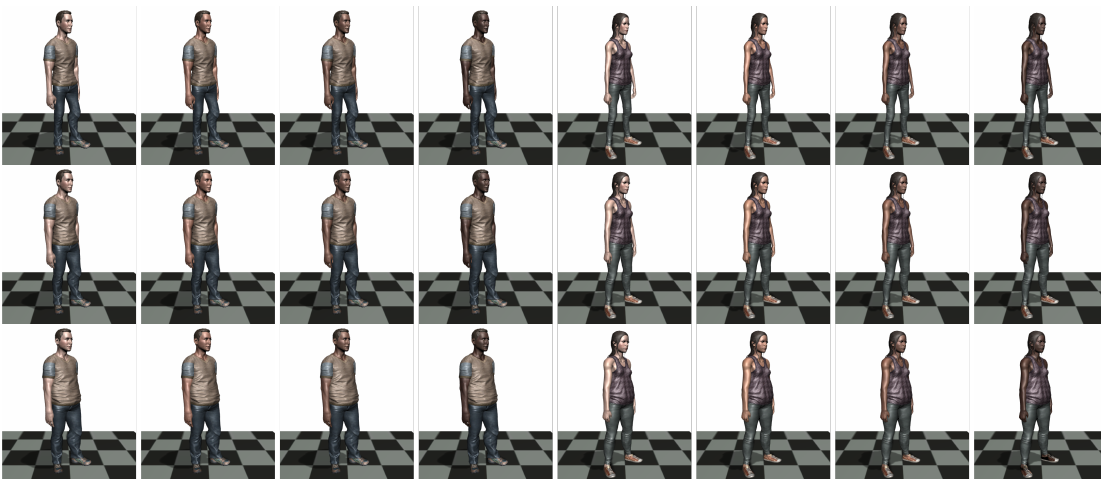
Figure 1. The different self-avatars designed and used in this experiment. Each participant was responsible for choosing the avatar that best represented him/her. The gender of the avatar was based on the gender identification part of the demographics